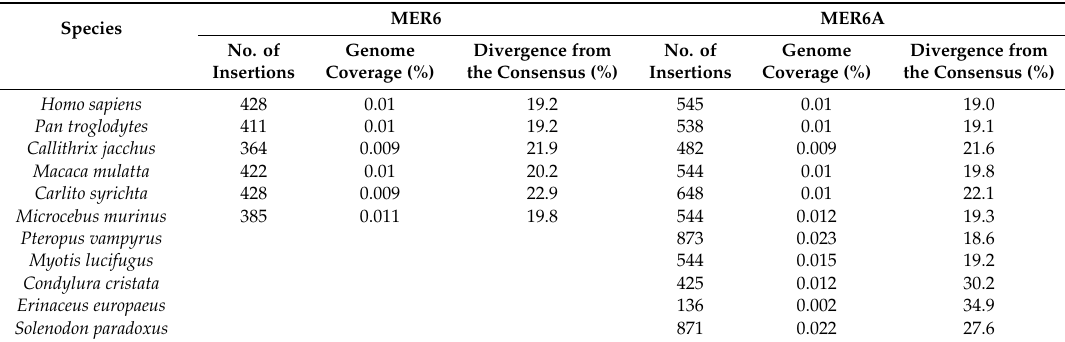
Table 1. Summary statistics of MER6 and MER6A assayed